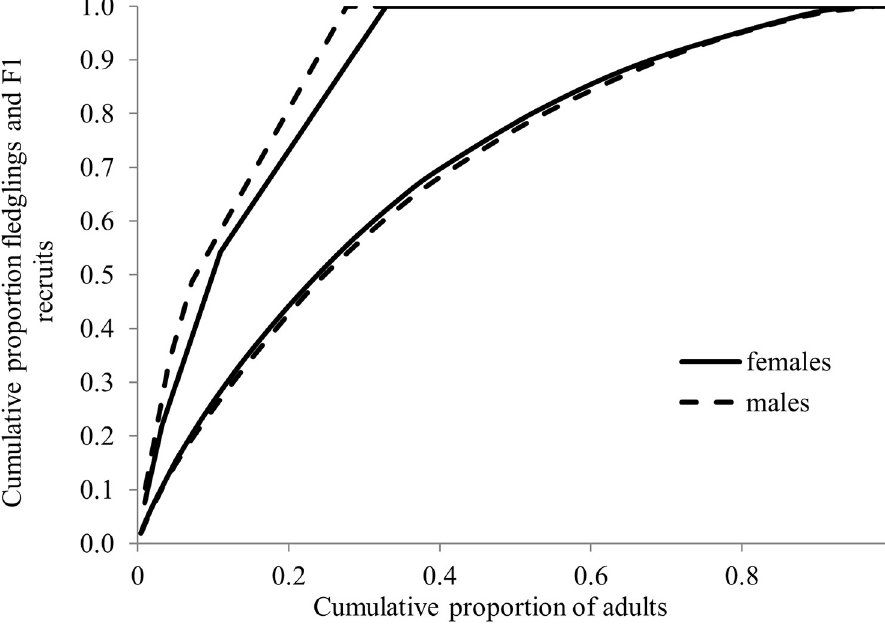
Fig 12. Proportion of total fledglings and F1 recruits produced by varying proportions of individual breeders. Proportional variation among 195 male and 250 female goshawks in total fledgling production and number of recruits to the local breeding population in Arizona, USA. Although 189 (96.4%) males and 238 (95%) females fledged young (lower curve), only 52 (27%) males and 71 (28%) females produced fledglings that recruited into the local breeding population (upper